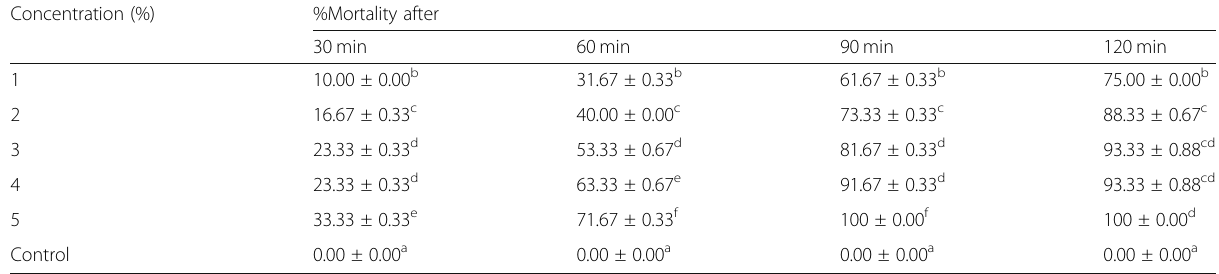
Table 1 Fumigant toxicity of leaf oil extract of P . alliacea on the mortality of adult Culex quinquefasciatus Concentration (%) %Mortality after 30 min